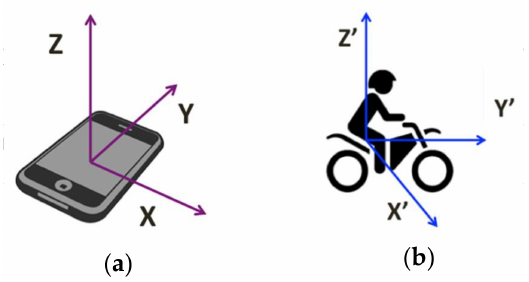
Figure 4. ( a ) The orientation of a smartphone given by ( X , Y , Z ) coordinate system. ( b ) The orientation of a vehicle given by ( X ’, Y ’, Z ’) coordinate